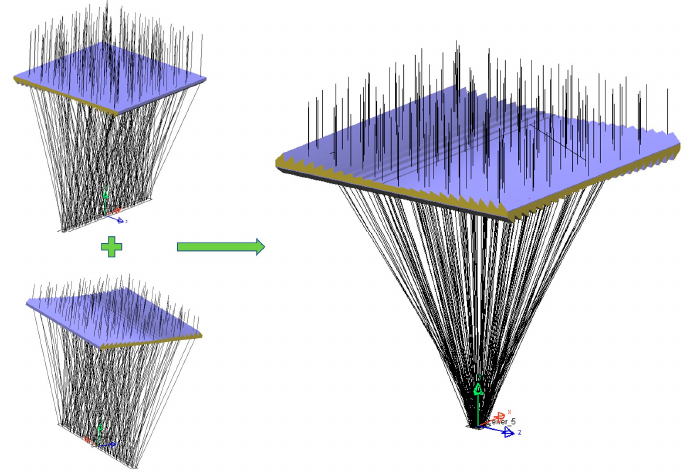
Figure 12. The ray tracing of sunlight convergence on two dimensions using the novel Fresnel lens with two groove surfaces (upper and lower surfaces) placed perpendicular to each other.